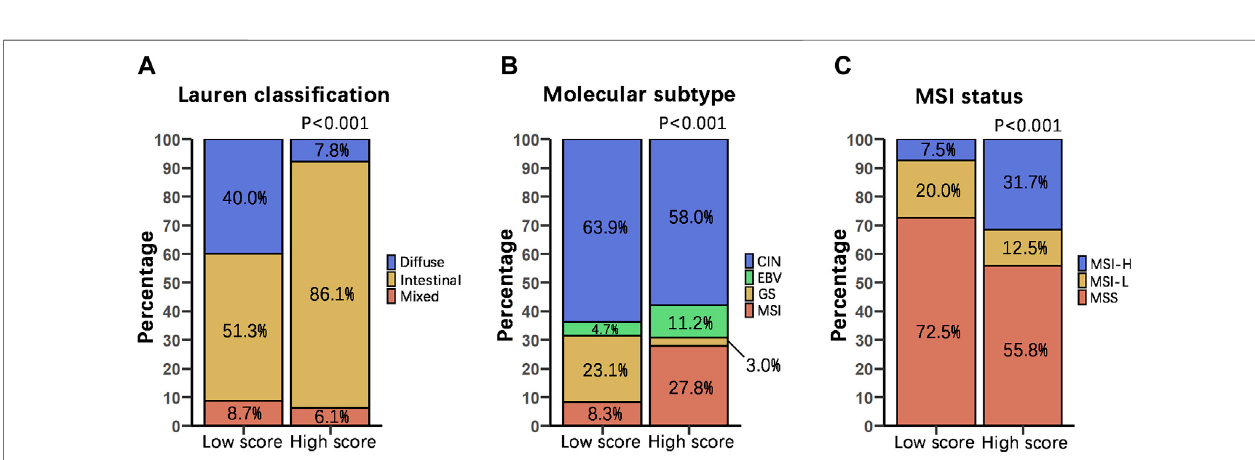
FIGURE 4 | Relationship between score grouping and other histologic and molecular classi fi cations. We compared the percentage distribution of the Lauren classi fi cation(Highscore n =115,Lowscore n =115) (A) ,molecularsubtype(Highscore n =169,Lowscore n =169) (B) ,andMSIstatusproportion(Highscore n =120, Low score n = 120) (C) of patients with DRGS high and low score using Chi-square test. In all cases, p is less than 0.001.